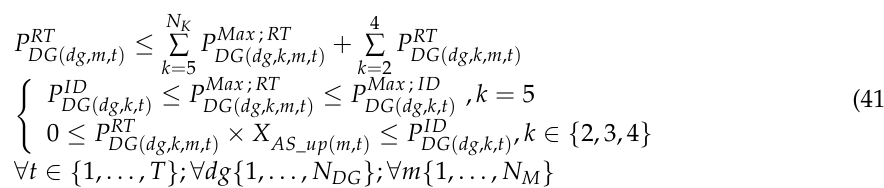
Table 1. Energy resources data. Energy